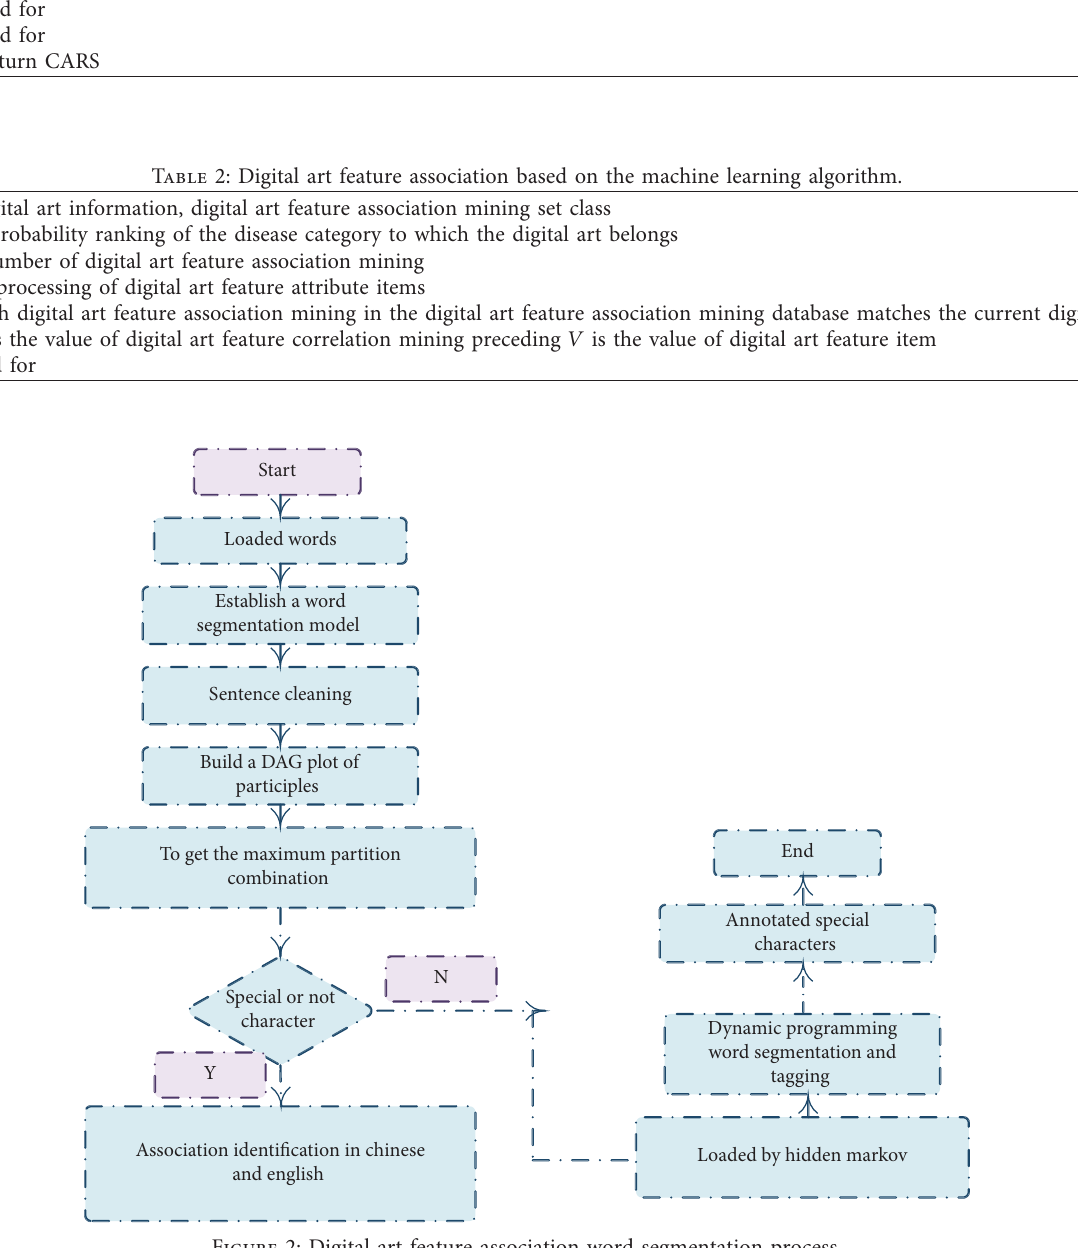
Figure 2: Digital art feature association word segmentation